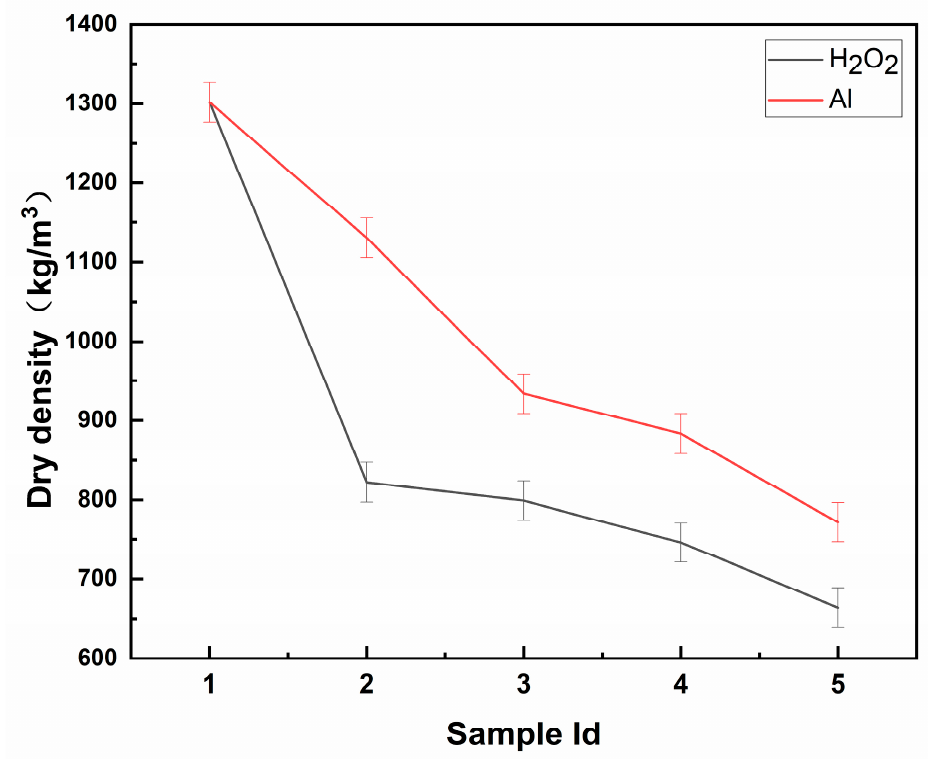
Figure 4. Influence of type and content of the foaming agent on the dry density of porous geopoly- mers.